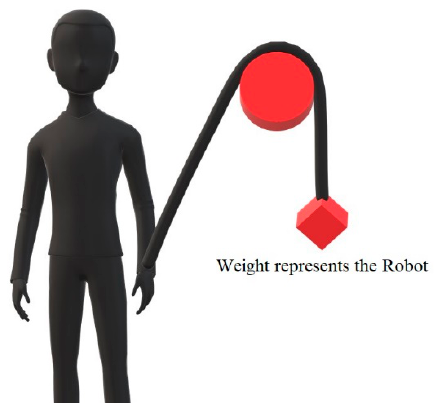
Figure 2. represents patient trying to perform the abduction and the adduction of the upper limb. The weight helps the patient to perform the abduction which represents the Active-Assistive therapy. Also, the weight prevents the patient performing the adduction which represents Active-Resistive therapy.